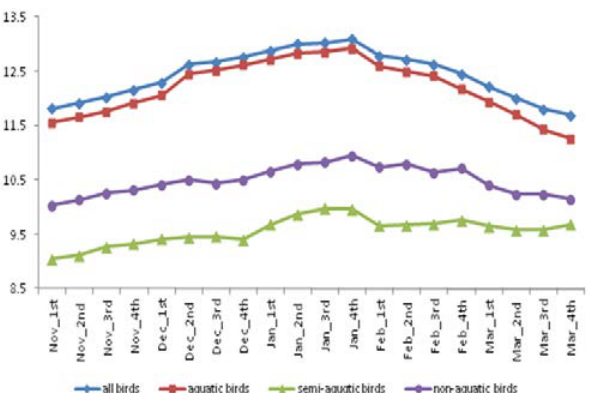
Fig. 3. Distribution of total avian population studied on all twelve wetlands. Y axis has log natural data of all individuals of all species coming under the categories. The data pertains to different winter weeks of 2010-11. Months are abbreviated to first three letters and week in ordinal